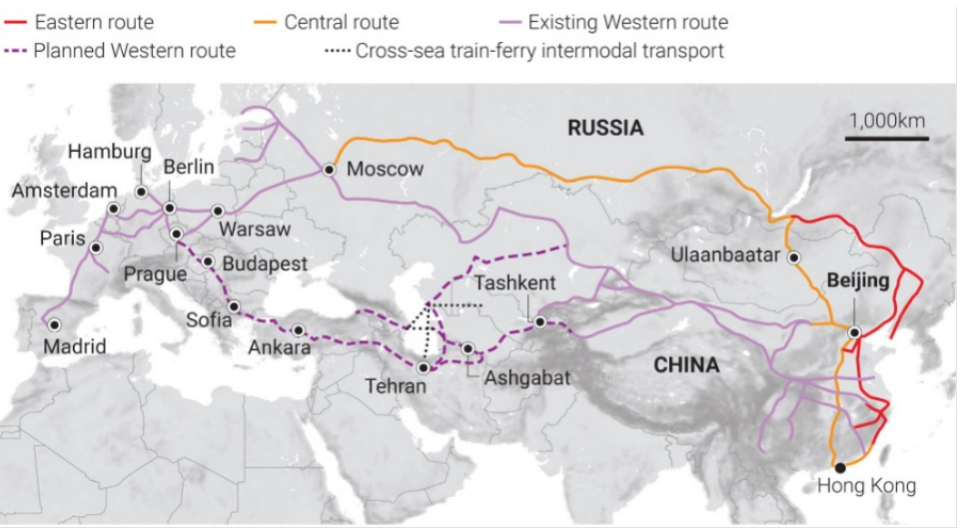
Figure 2. The planned routes of China Rail Express. Source: https://www.scmp.com/economy/glo bal-economy/article/3169239/what-china-europe-railway-express-and-how-much-pressure-it, 27 April